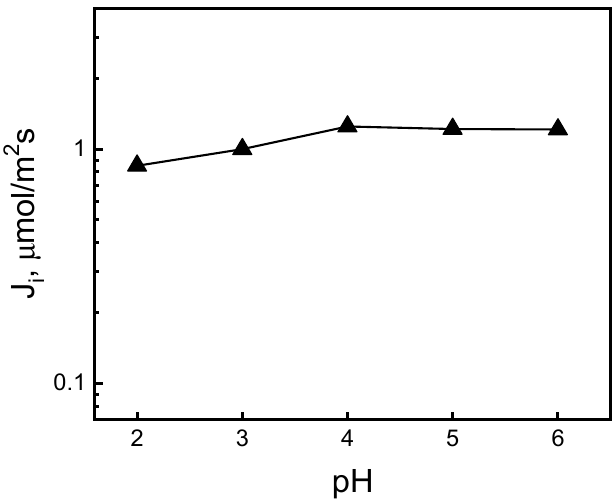
Figure 1. The relationship of the initial ion flux of Ag(I) transport across the PIM vs. the pH of the source phase. Source phase: 5.0 × 10 − 4 M AgNO 3 ; membrane: 2.0 cm 3 o -NPPE / 1.0 g CTA; 0.050 M KP, receiving phase: 0.10 M thiourea .